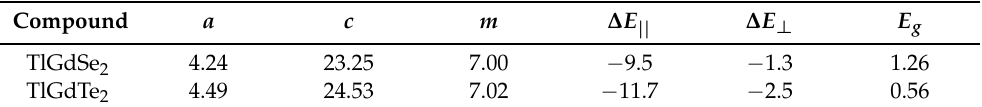
= E − || NCAFM − E FM , meV/[Gd AFM